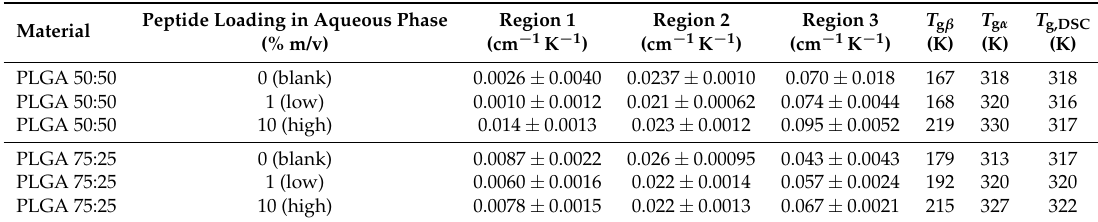
Table 1. Gradient, m , of the linear fit ( y = mx + c ) for the respective temperature regions as outlined in Section 2.8.2 as well as the respective glass transition temperatures determined based on the terahertz analysis and by